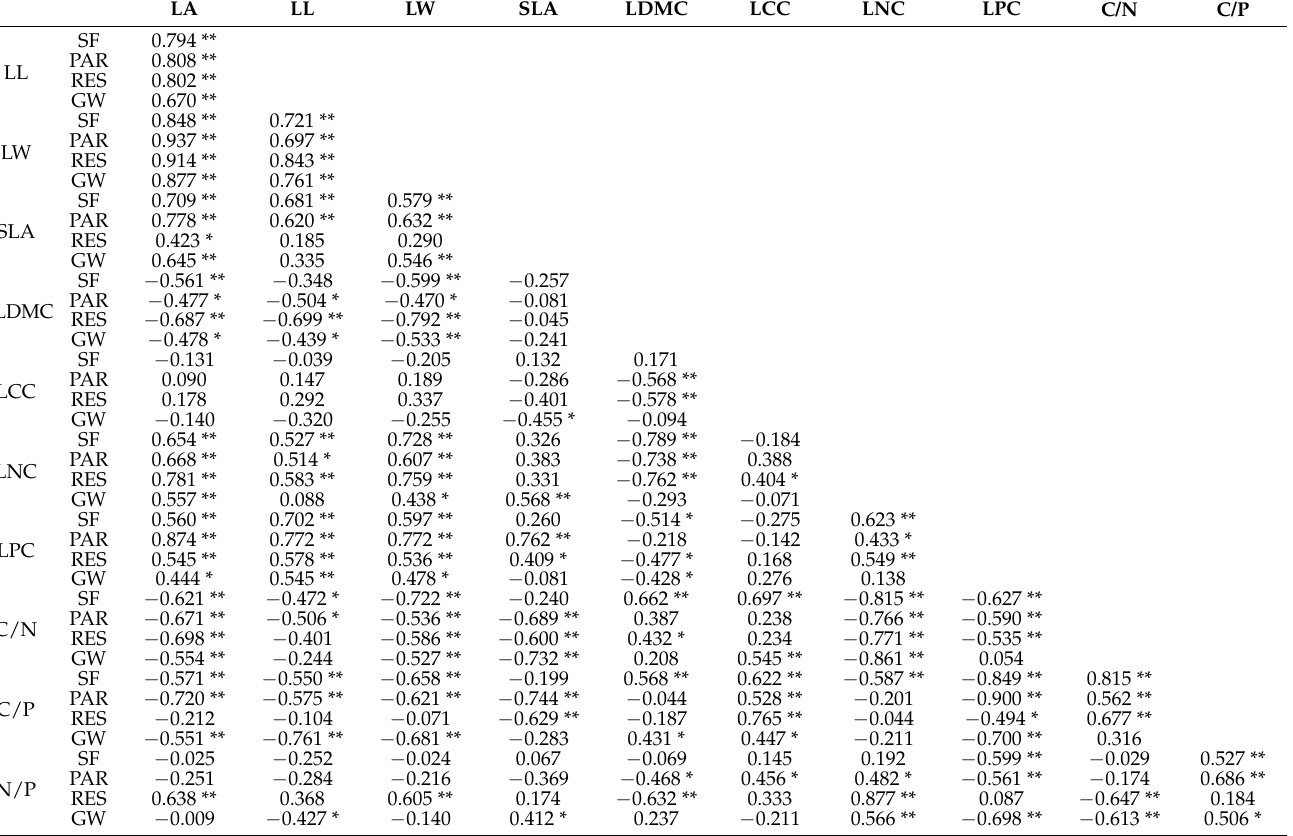
Table 5. Pearson correlation of morphological traits and leaf nutrient traits of eight landscape plants among four green space environments. SF, sport field; PAR, park; RES, residential green space; GW, greenway. LL, leaf length; LW, leaf width; LA, leaf area; SLA, specific leaf area; LDMC, leaf dry matter content. LCC, leaf carbon content; LNC, leaf nitrogen content; LPC, leaf phosphorus content; C/N, leaf carbon/nitrogen ratio; C/P, leaf carbon/phosphorus ratio; N/P, leaf nitrogen/phosphorus ratio. * Represents p < 0.05; ** represents p < 0.01.